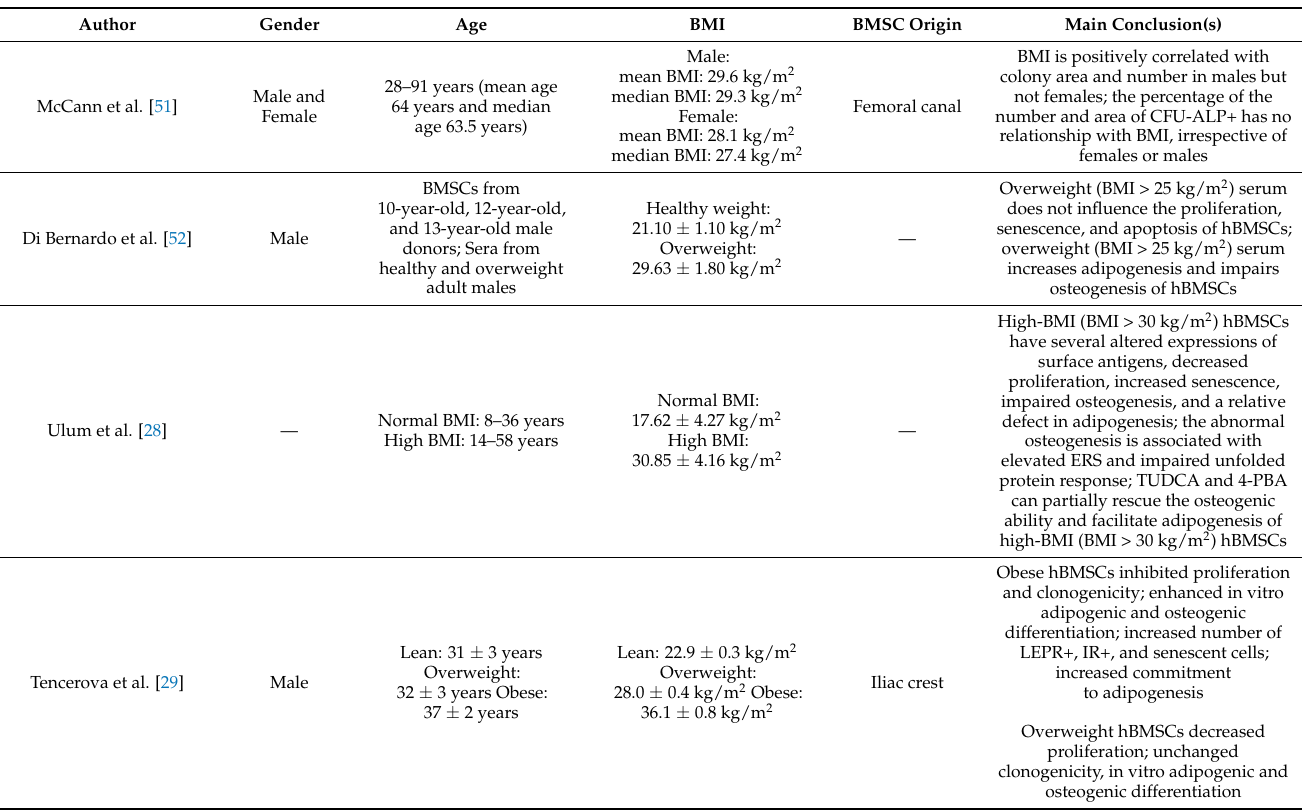
Table 2. Human studies included in the